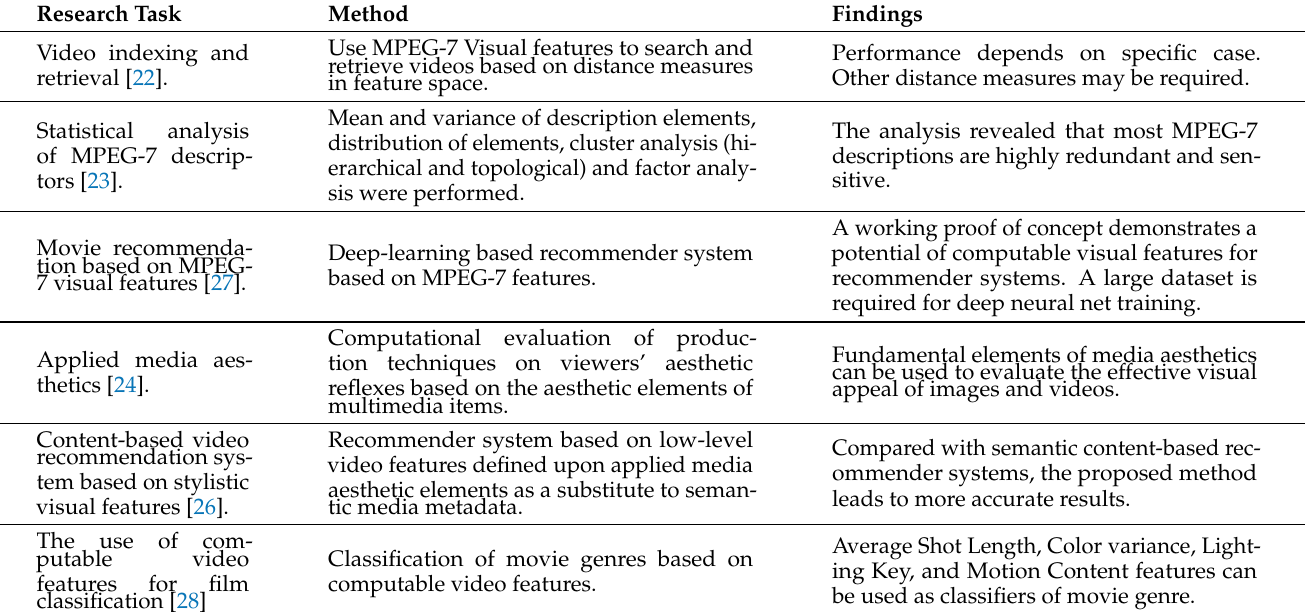
Table 2. Contributions of related work regarding the applications of computable low-level video